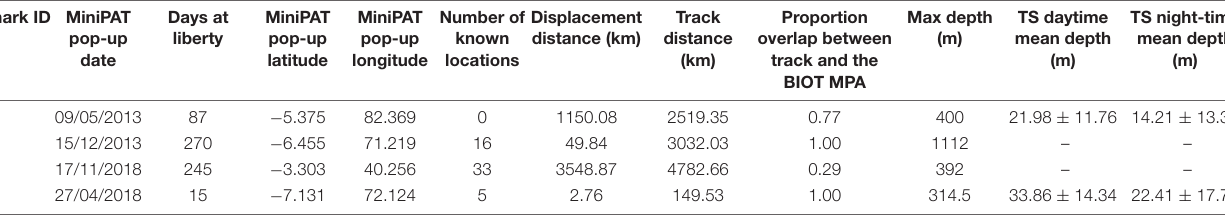
TABLE 2 | Satellite tag (MiniPATs, Wildlife Computers) deployments on silky sharks ( Carcharhinus falciformis) around the Chagos Archipelago between 2013 and 2018. Shark ID MiniPAT